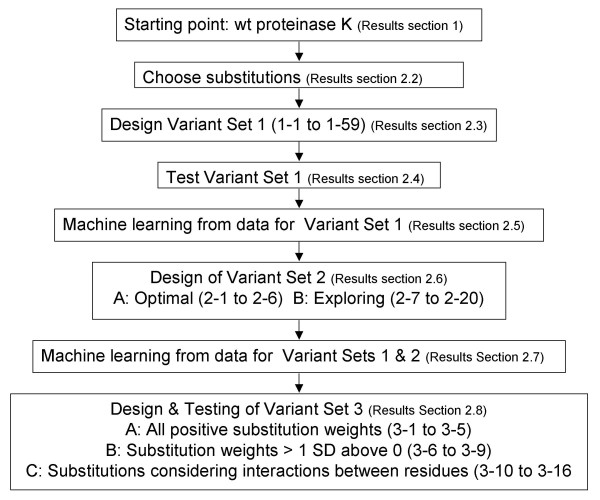
Flowchart of protein engineering design and testing process. The figure shows an overview of the experimental flow described in this work. Details are provided for each step in the indicated section of Results and Discussion.